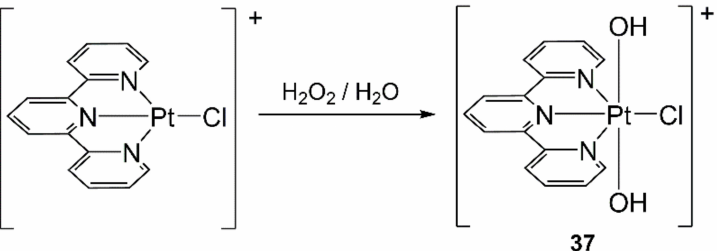
Figure 12. Scheme of the oxidation reaction of [PtCl(terpy)] + (terpy = 2,2 (cid:48) :6 (cid:48) ,2 (cid:48)(cid:48) -terpyridine). Reaction of Pt(IV) complexes that contain one or two hydroxide ligands with acyl chlorides in acetone, in the presence of pyridine, was faster with MW heating (reflux overnight vs. heating the MW vessel to 55 ◦ C over a 5 min ramp period and then holding at this temperature for 1 h at 50 W)